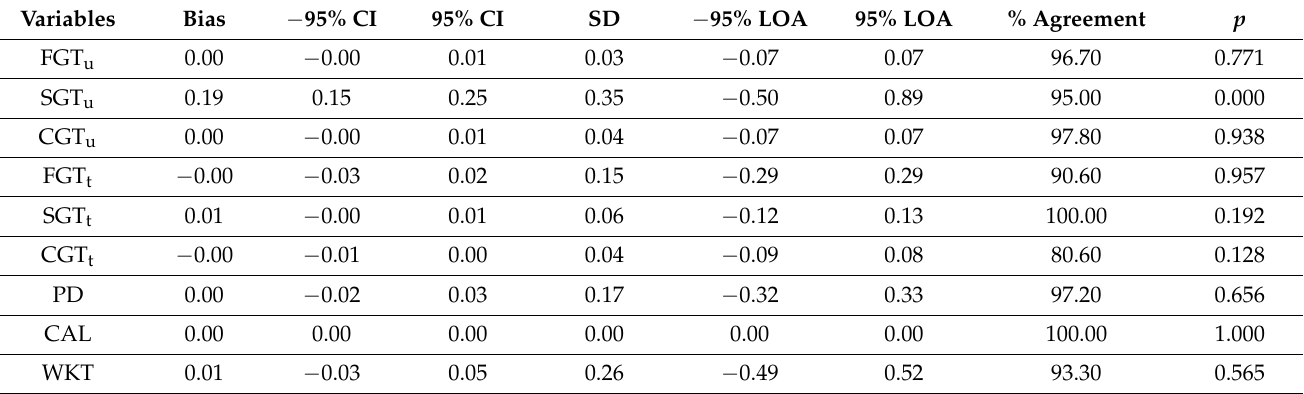
Table 3. Intra-examiner agreement of measurement performed by the second examiner (W.B.).